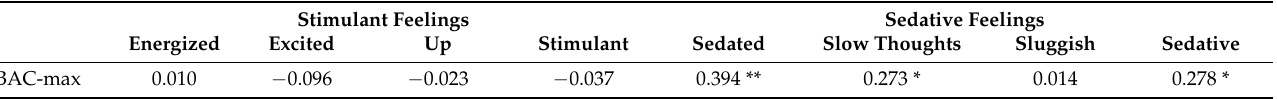
Table 4. Relationship of BAC-max with each maximal score of subjective feeling in the crossover trial. Stimulant Feelings Sedative Feelings Energized Excited Up Stimulant Sedated Slow Thoughts